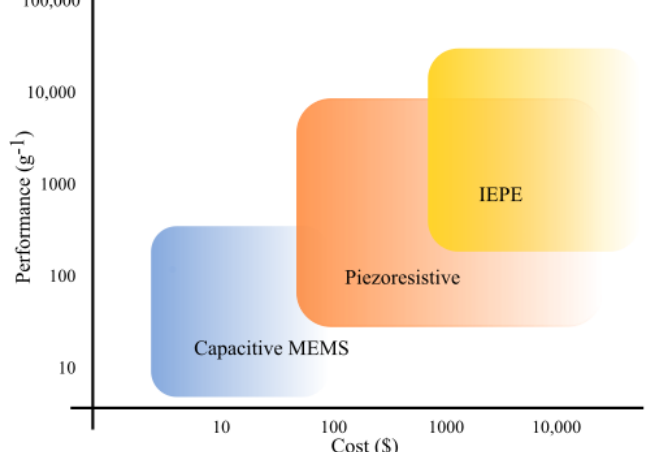
Figure 1. Comparison of performance versus cost for the three main types of